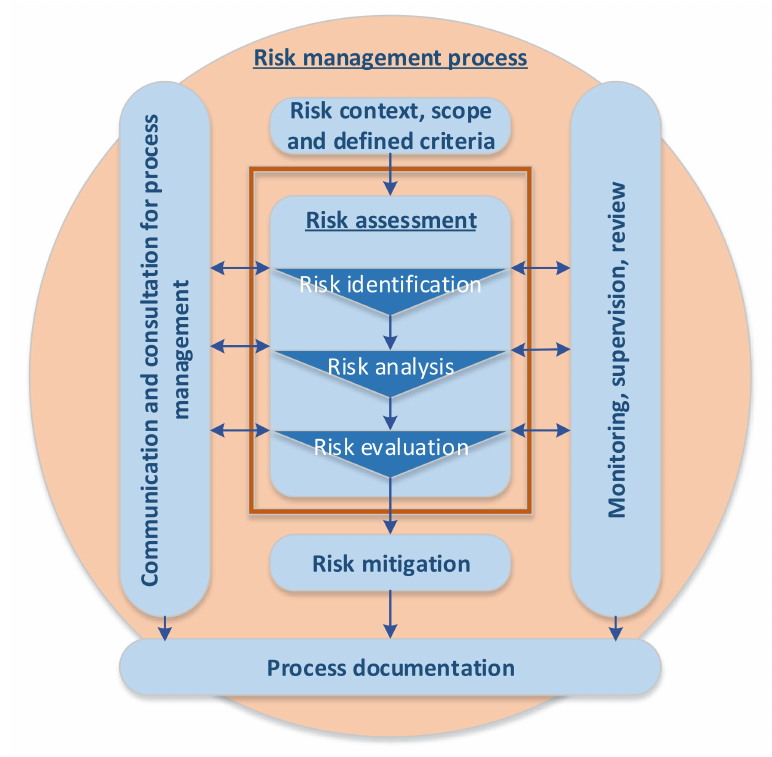
Figure 4. Risk management process, own work, based on